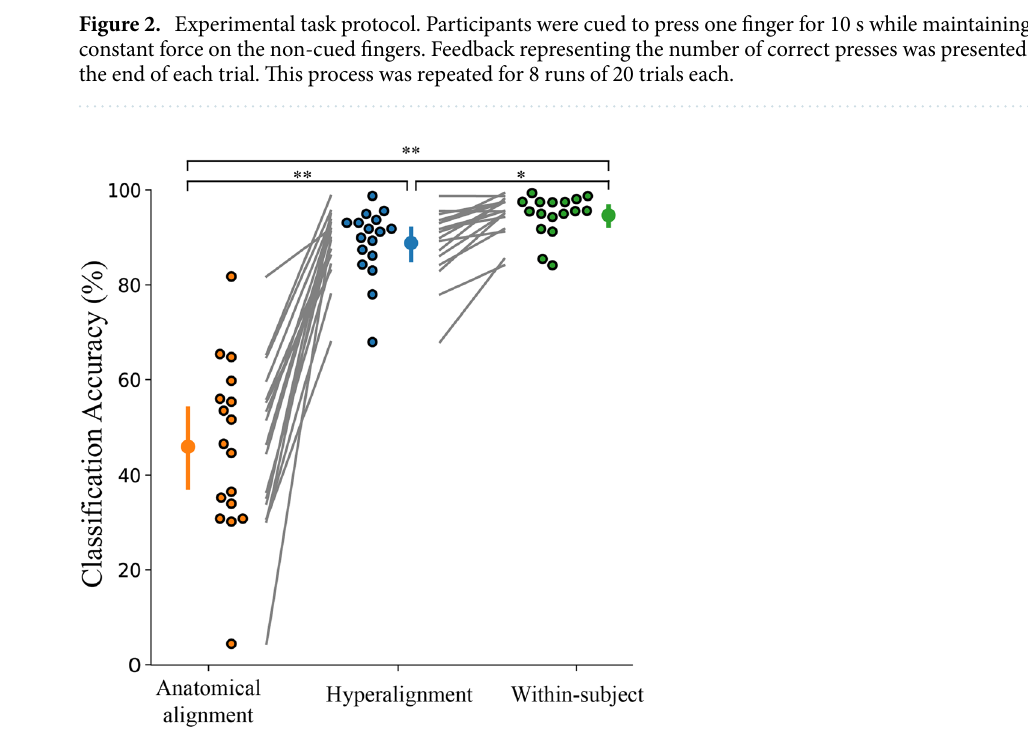
Figure 3. Hyperalignment provides better between-subject classification accuracy (88.8%) than conventional anatomical alignment (46.0%). Within-subject classification (94.7%) is also included for comparison. Individual participants are presented beside the mean as circles with a black outline. Error bars indicate a 95% confidence interval. * p < 0.05, ** p <